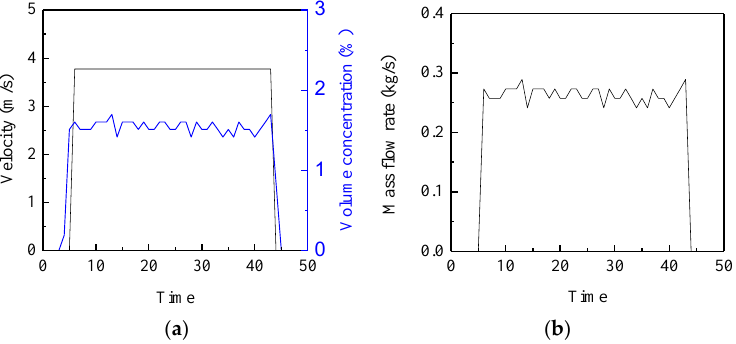
Figure 15. Continuous measurement results for a typical valve opening: ( a ) Particle velocity and concentration; ( b ) Mass flow rate.